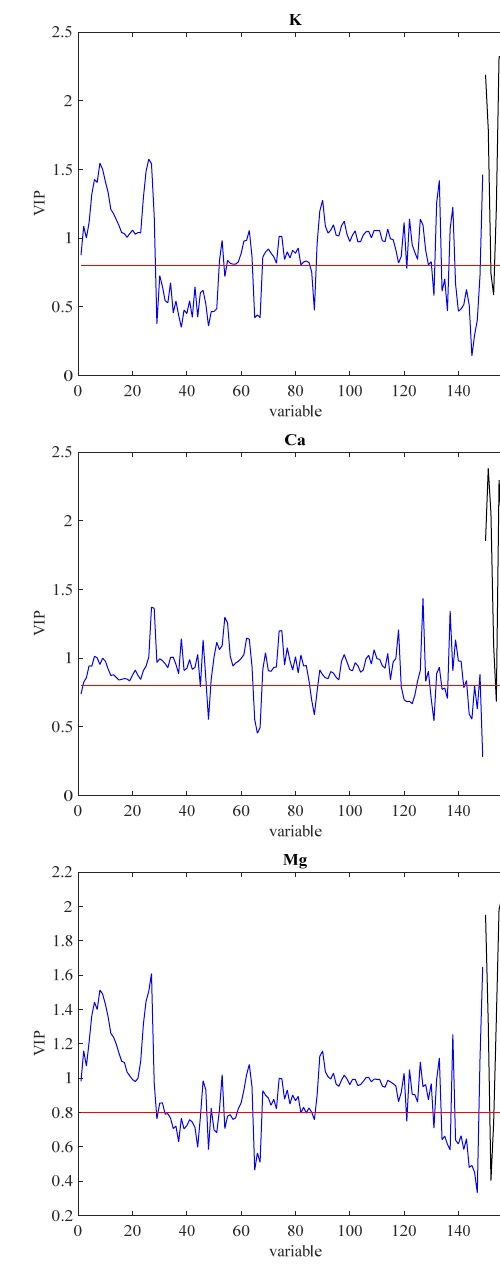
Figure 8. Variable importance of projection (VIP) values for the partial least squares (PLS) regression predictive models. Left column shows the values derived using only IS data and right column shows the values using IS and LiDAR data together for N, P, K, Ca and Mg, respectively. The black line in the right column graphs represents LiDAR data. The x-axis in the right column graphs represents the same 149 wavelengths in the left column graphs and additionally the LiDAR data. The red line indicates Wold’s criterion value of